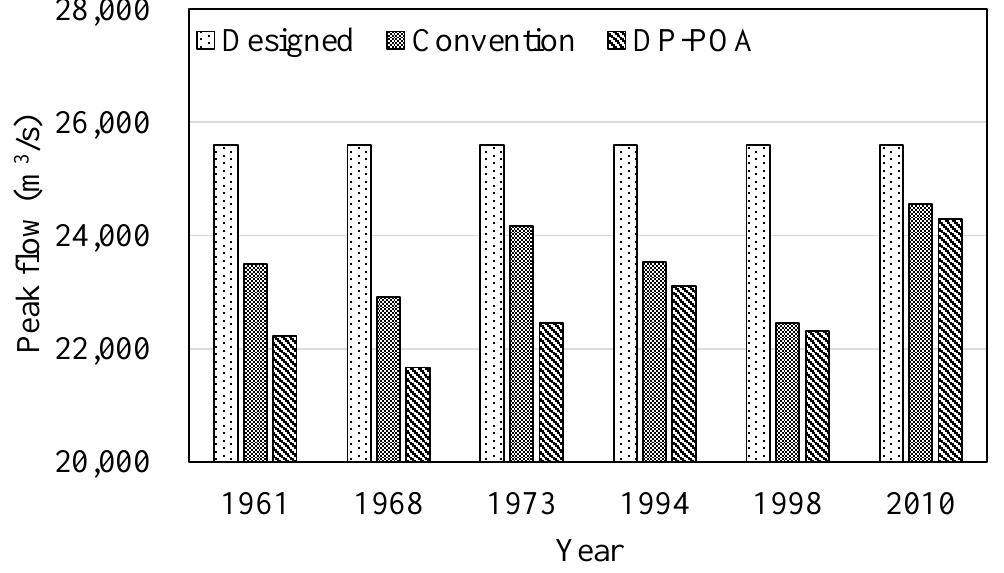
Figure 7. Flood peaks of the Waizhou flood control point with 100-year return period.